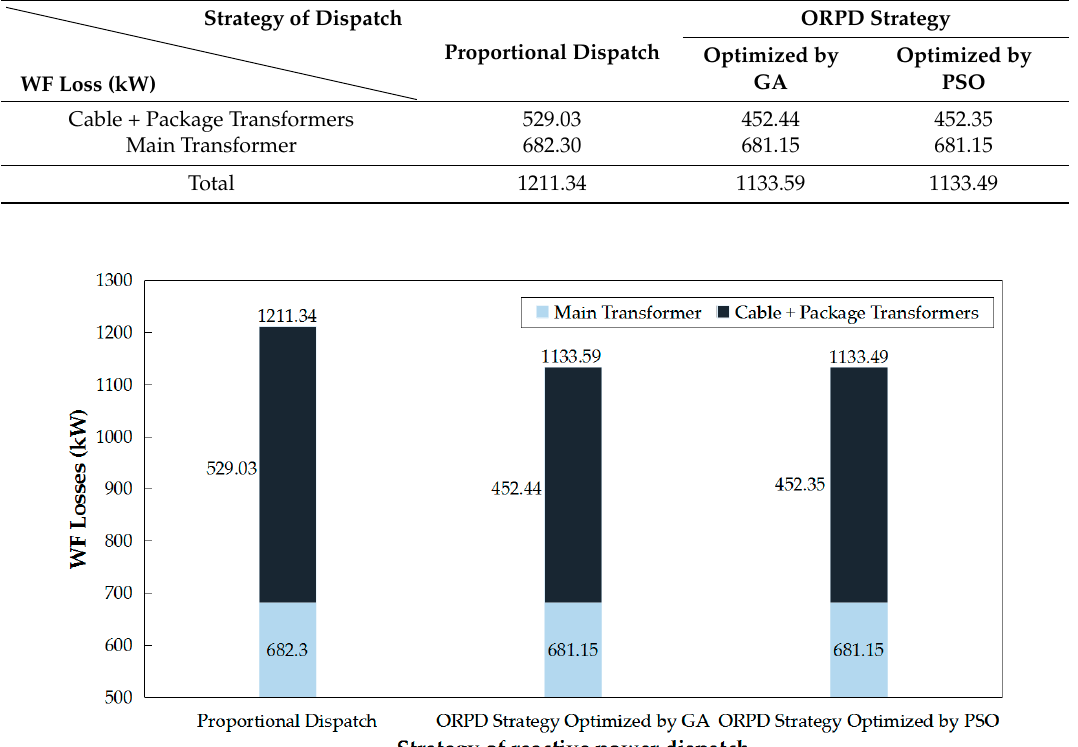
Table 1. Losses in the WF using different dispatching strategies.